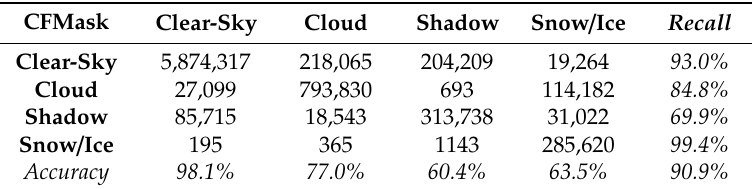
Table 2. Agreement between CFMask quality masks and the manually labeled imagery across all eight evaluation scenes, with class-wise accuracy and recall statistics (italics). The ‘water’ class is not distinguished by CFMask and is included with